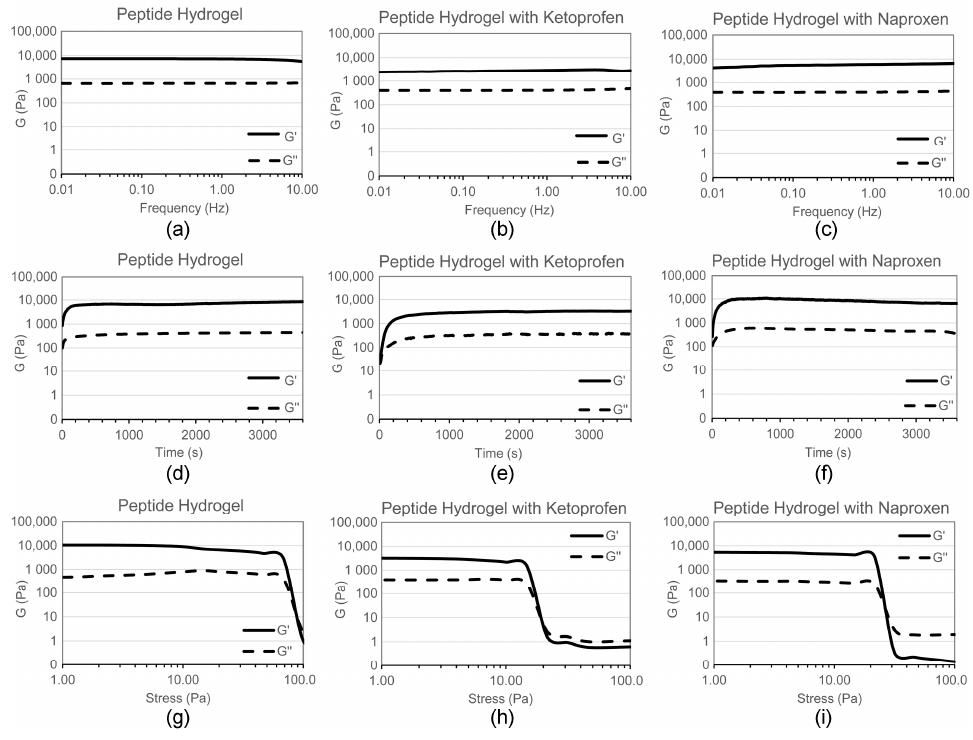
Figure 2. Oscillatory rheometry analysis of hydrogels ( a – c ) frequency sweeps; ( d – f ) time sweeps; ( g – i ) stress sweeps.